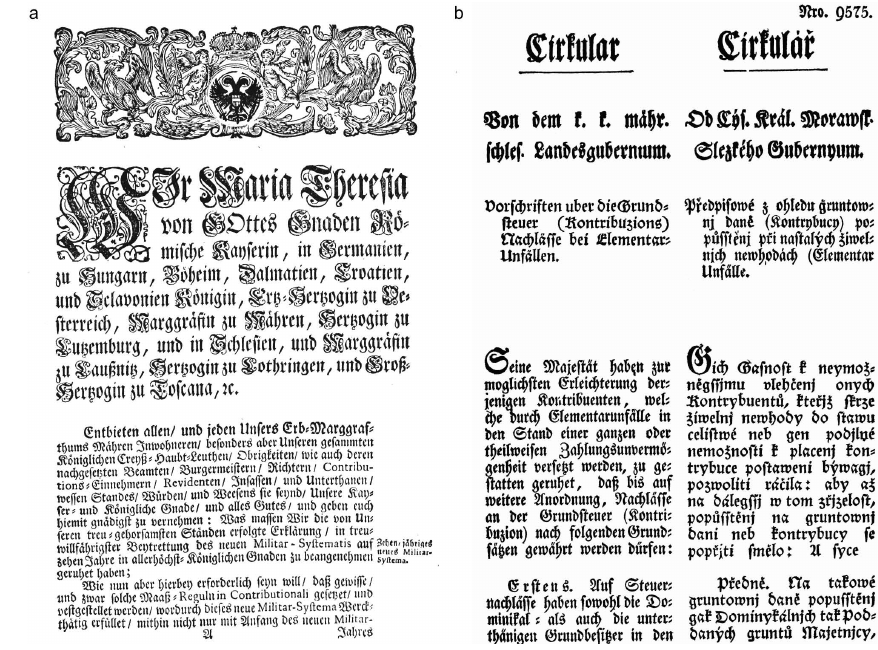
Fig. 2. Title pages of documents relating to tax payments in the event of damage to crops caused by hydrometeorological phenomena: (a) decree of Empress Maria Theresa, 26 July 1748; (b) circular No. 9575 of the Moravian-Silesian Gubernium, 23 April